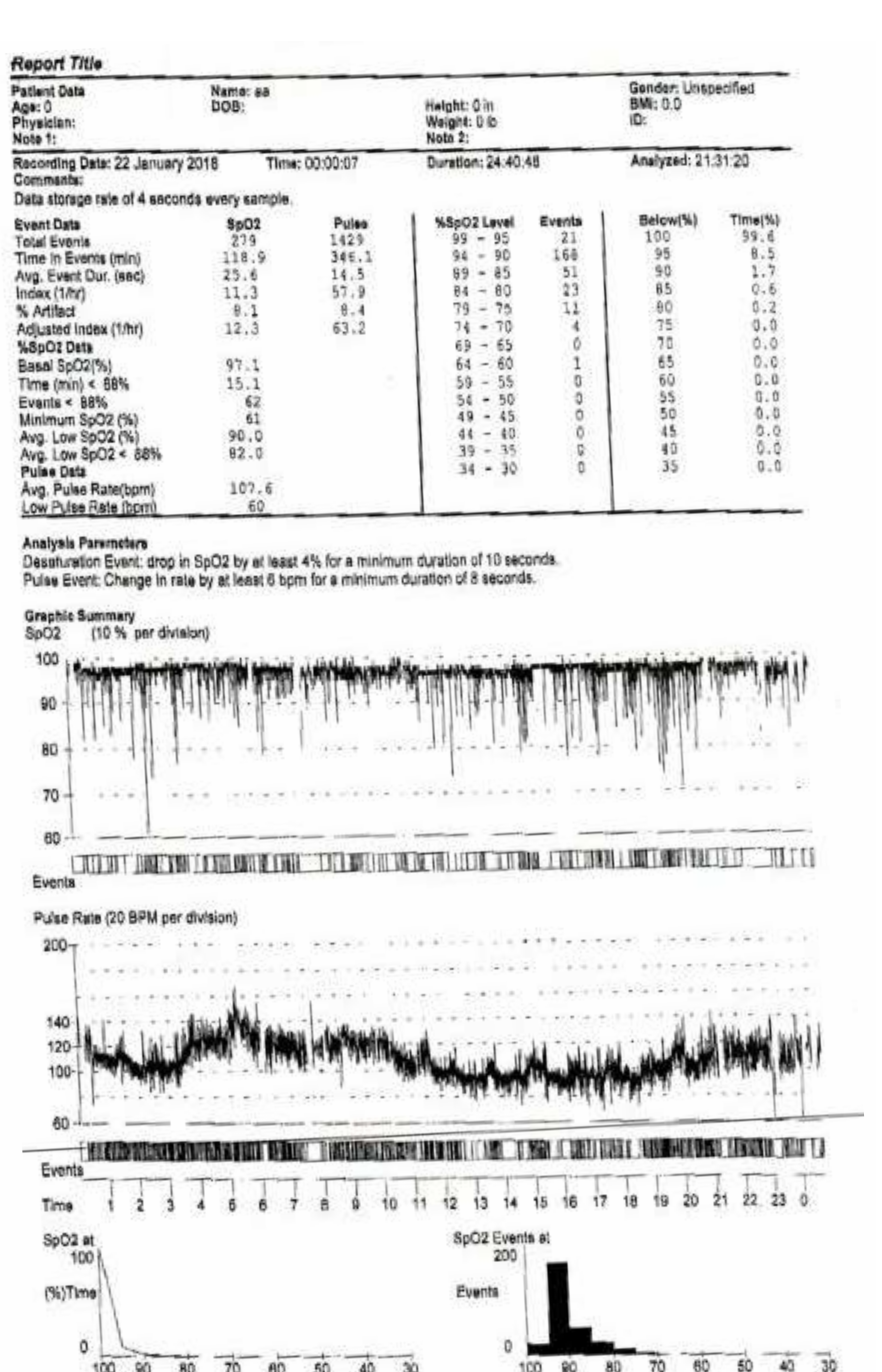
Figure 5. Overnight oximetry demonstrating normal baseline oxygen saturation and frequent oxygen desaturations suggestive of central sleep